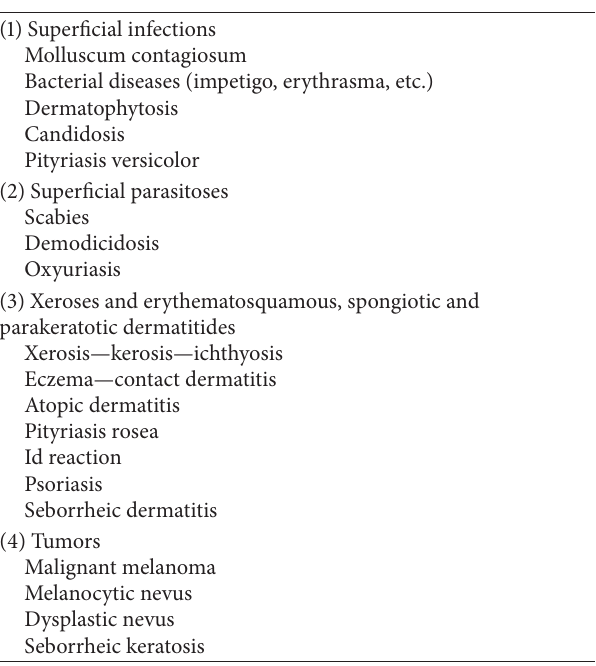
Table 1: Indications for surface